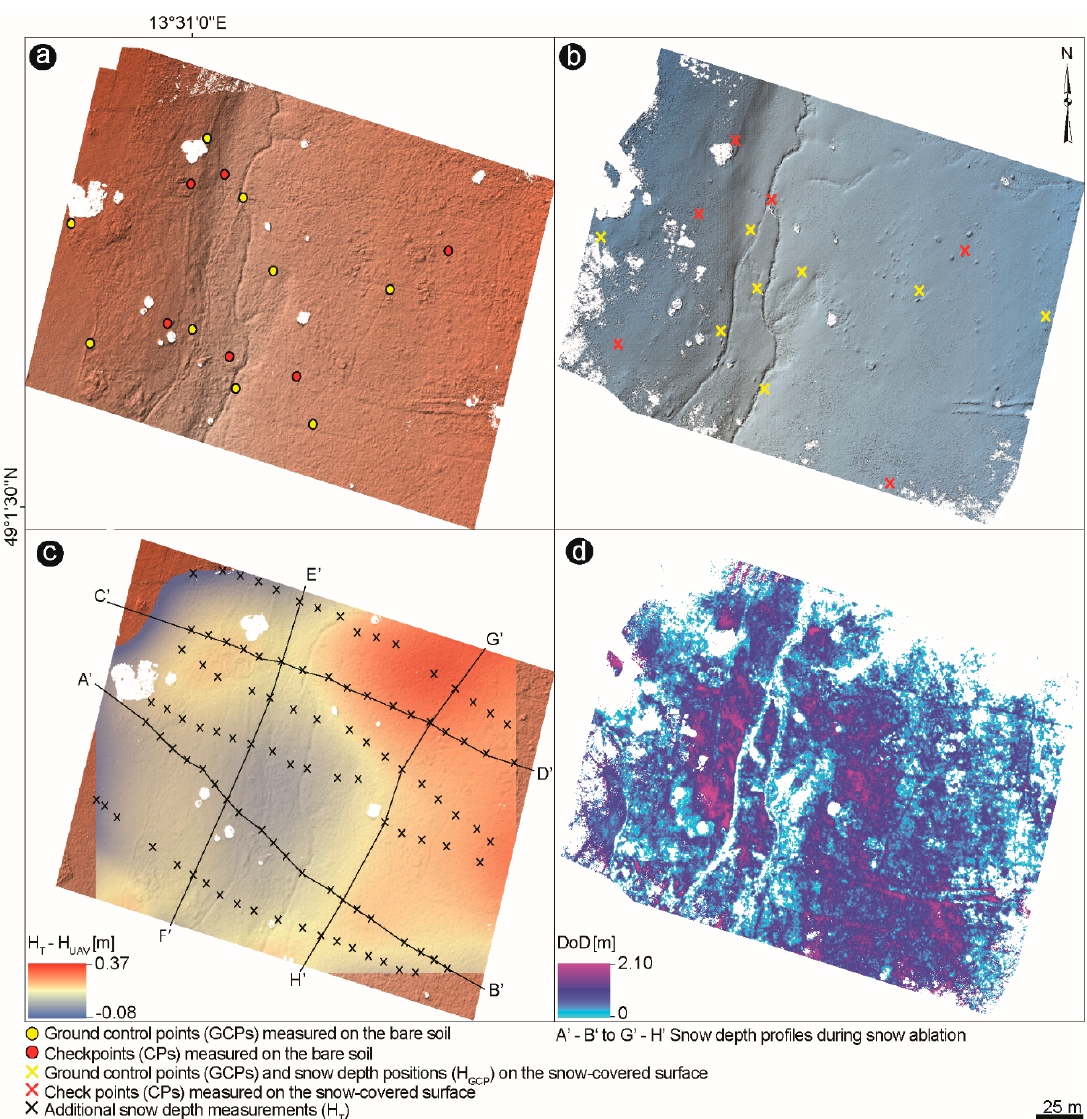
Figure 5. ( a , b ) Hillshaded snow-free and snow-covered DSMs and detail surface visualization of the open site (Filipova Hut) with the applied ground control points (GCPs) and checkpoints (CPs). GCPs taken during snow cover served as well as reference snow depth points at the GCP positions (H GCP ; pink crosses). Overlapping snow-free and snow-covered GCPs were selected in support of co-georeferencing the snow-free DSM with the snow-covered DSM. ( c ) Map of interpolated spatial distribution of the snow height differences between the supplementary H T probes and estimated H UAV measurements underlying the bare soil hillshade ( d ) DSM of difference (DoD), produced by subtracting the snow-covered DSM from the snow-free DSM.